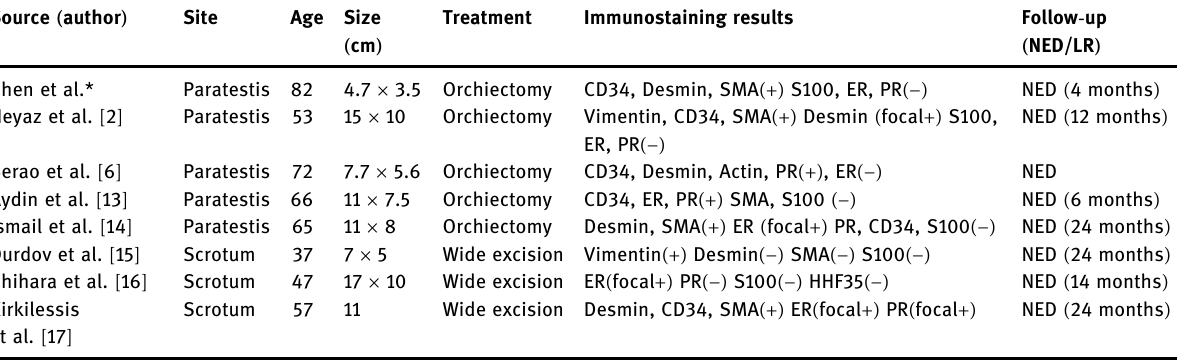
Table 1: Clinical details of paratesticular angiomyxoma in a literature